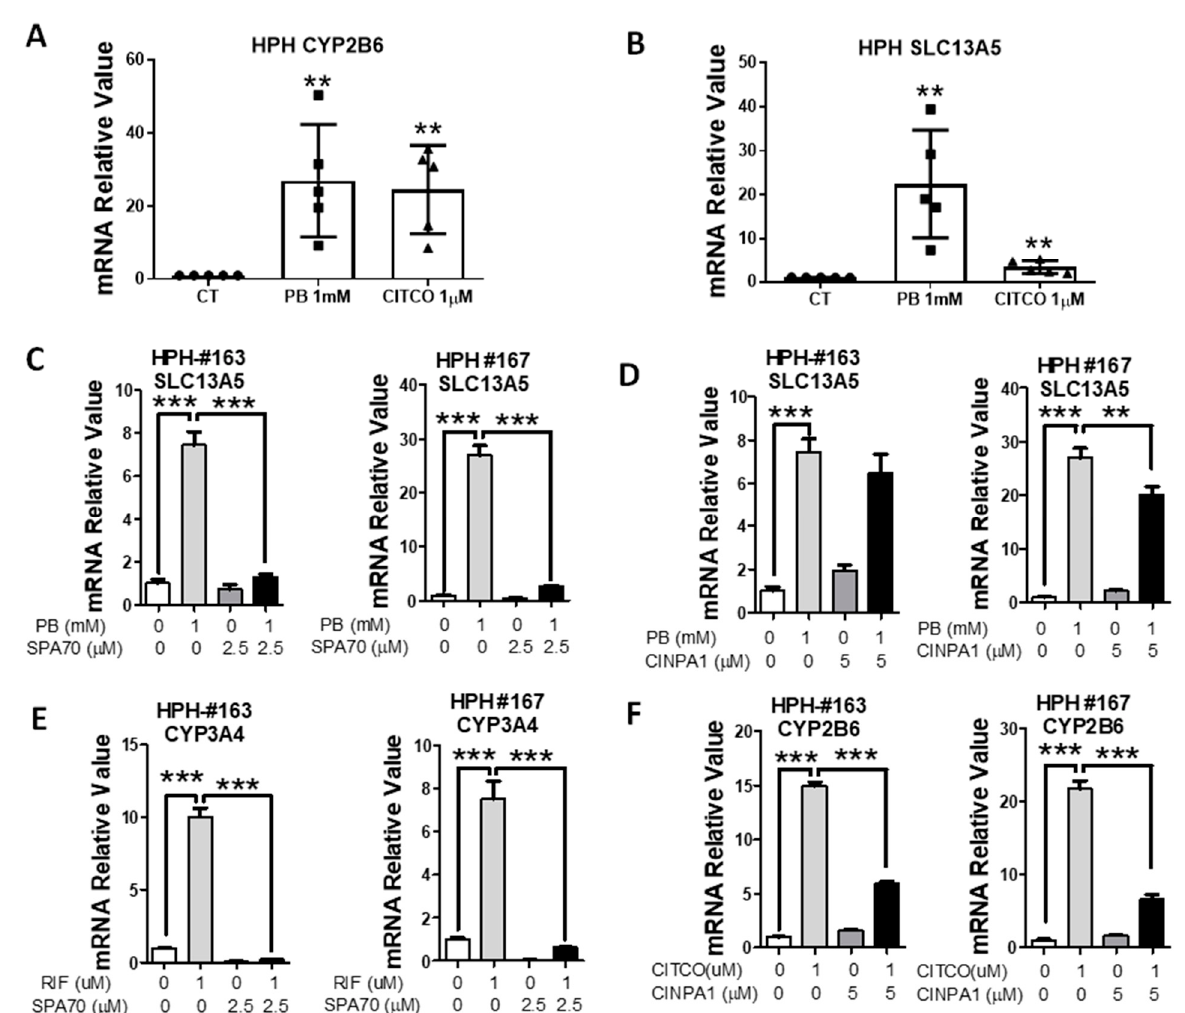
Figure 2. PXR inhibitor suppresses PB-mediated induction of SLC13A5 in HPH. HPH prepared from five liver donors were treated with 0.1% DMSO (CT), PB (1 mM), or CITCO (1 μ M) for 24 h. RT-PCR analysis was used to measure the expression of CYP2B6 ( A ) and SLC13A5 ( B ). In separate experiments, HPH from liver donors (HPH #163, #167) were treated with 0.1% DMSO, PB (1 mM), RIF (10 μ M), CITCO (1 μ M), or in combination with SPA70 (2.5 μ M) ( C and E ), and CINPA1 (5 μ M) ( D and F ) as detailed in Materials and Methods. RT-PCR was used to measure mRNA expression of SLC13A5 ( C , and D ), CYP3A4 ( E ), and CYP2B6 ( F ). Data are expressed as the mean ± S.D. ( n = 3 − 5), ** p < 0.01; *** p < 0.001.